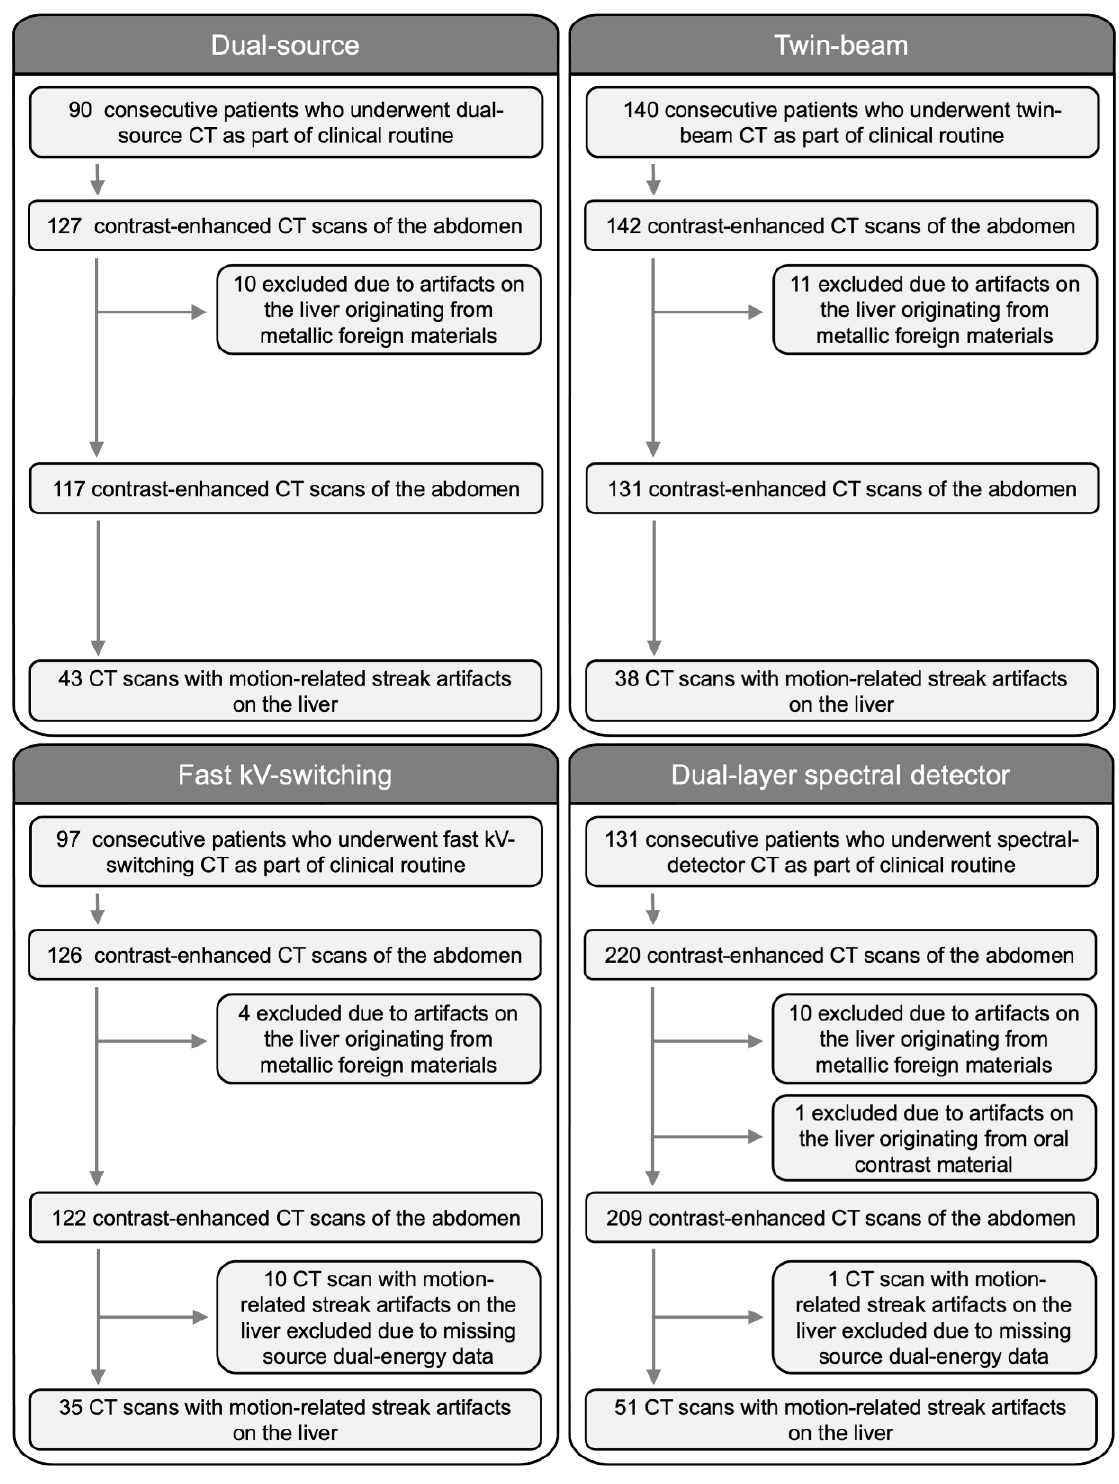
Figure 1. Flow chart of the study population. In total 615 contrast-enhanced CT scans of the abdomen in 458 patients (mean age: 61 ± 14 years, 331 men) were evaluated. Dual-source: 90 patients (mean age: 58 ± 14 years, 50 men). Twin-beam: 140 patients (mean age: 51 ± 19 years, 72 men). Fast kV- switching: 97 patients (mean age: 66 ± 11 years, 89 men). Dual-layer spectral detector: 131 patients (mean age: 68 ± 10 years, 120